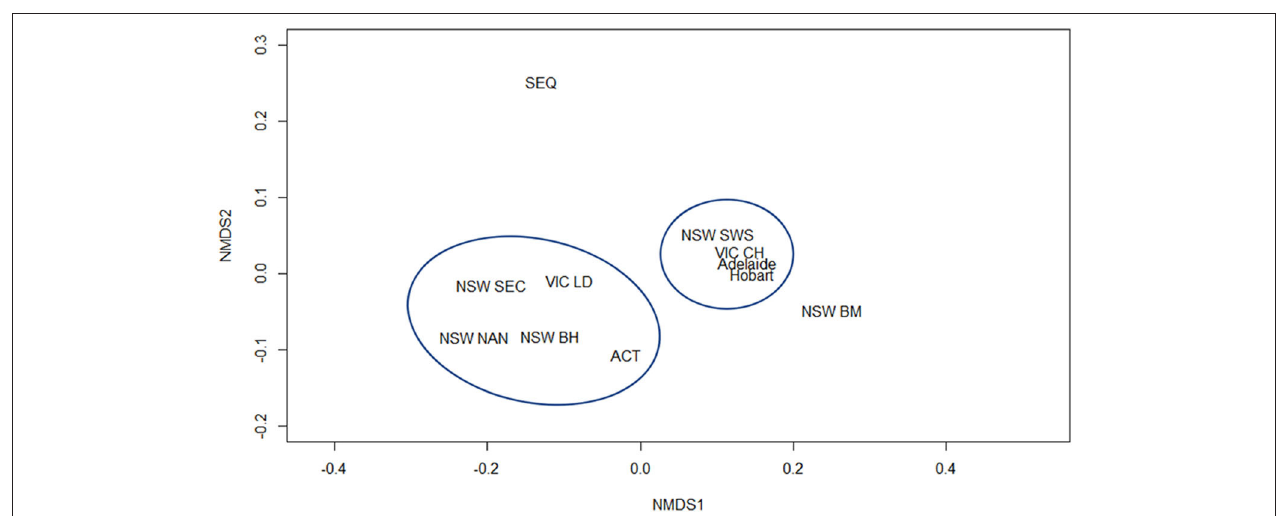
FIGURE 8 | Non-metric multidimensional scaling results of normalized cost data.